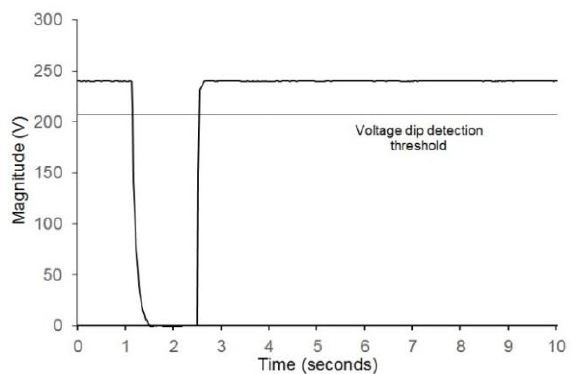
Figure 4. An example of a short interruption in a DC power source.